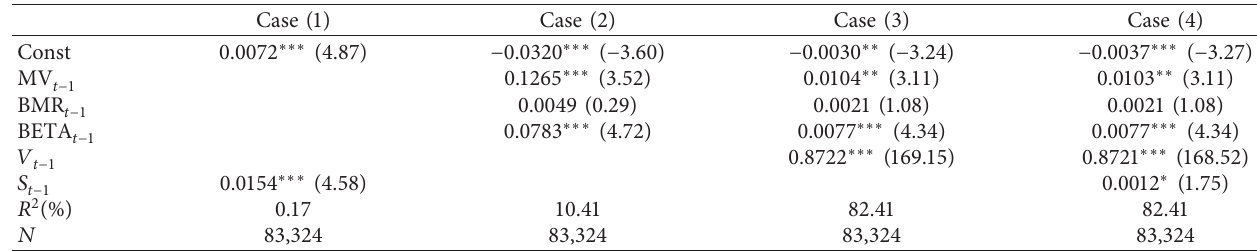
Table 6: Regression results of investor sentiment and trading volume.